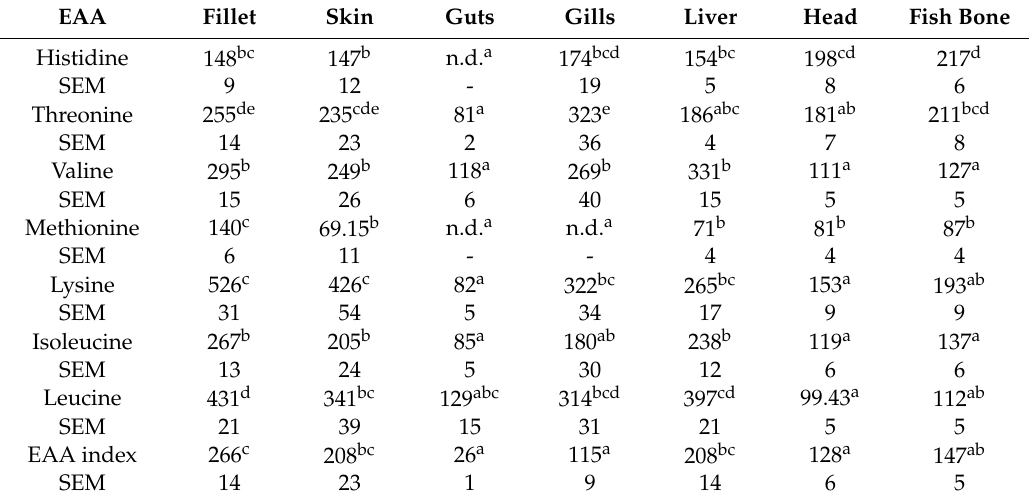
Table 3. Amino-acid scores and index of sea bass fillet and by-products.